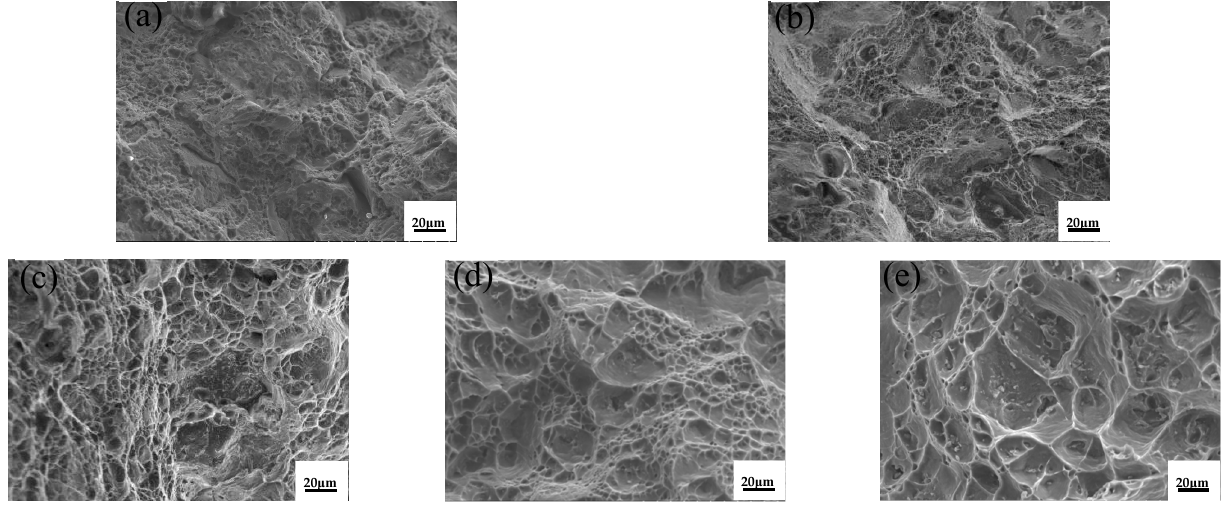
Figure 10. Tensile fracture morphology of ZL205A alloy with 0.1%La + 0.3%Al–5Ti–0.8C at different temperatures: ( a ) 25 ◦ C, ( b ) 100 ◦ C, ( c ) 200 ◦ C, ( d ) 250 ◦ C, and ( e ) 300 ◦ C.